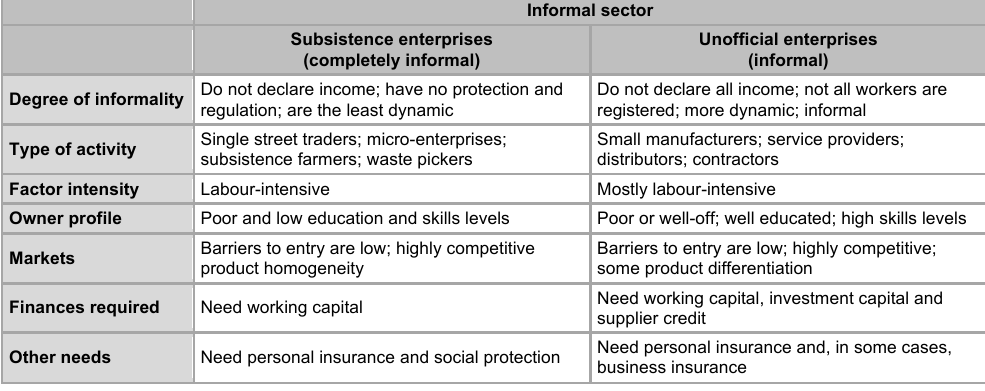
Characteristics of subsistence and unofficial enterprises in the informal economy Informal